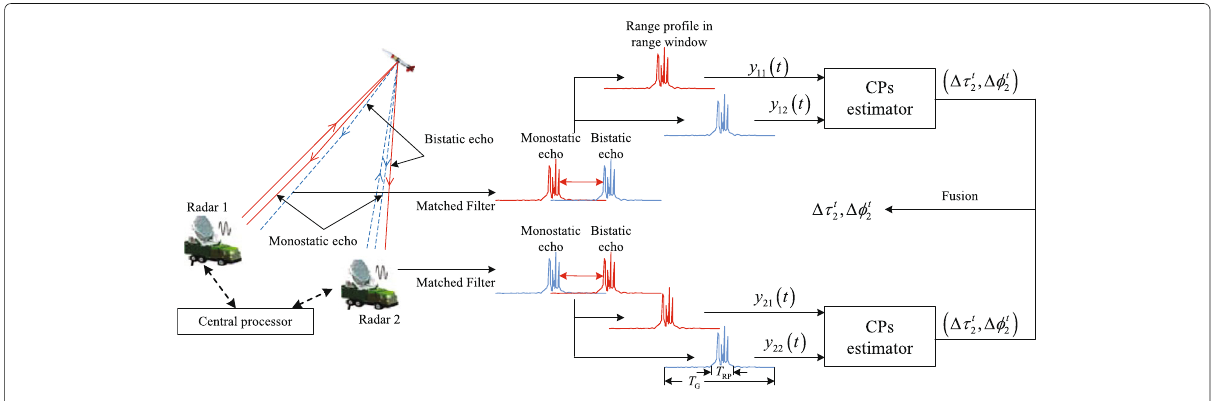
Fig. 1 Framework of transmit CP estimation for dual radar